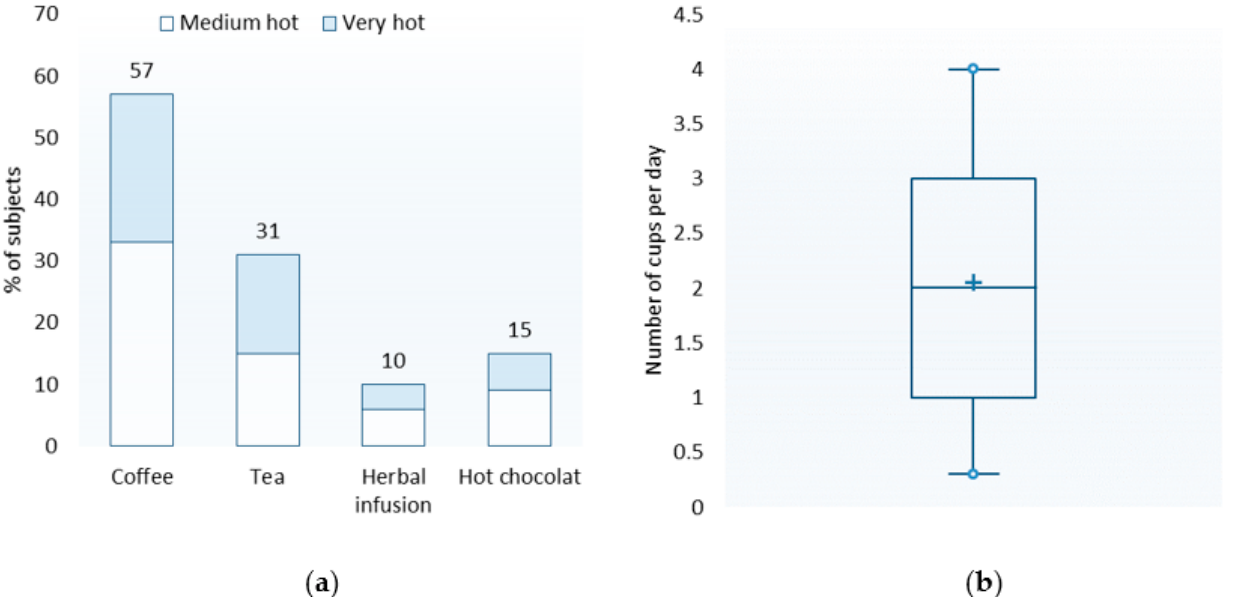
Figure 6. Favorite drink. ( a ) Percentage of subjects per drink and usual temperature level of consumption. ( b ) Distribution of consumption frequencies for the favorite drink.